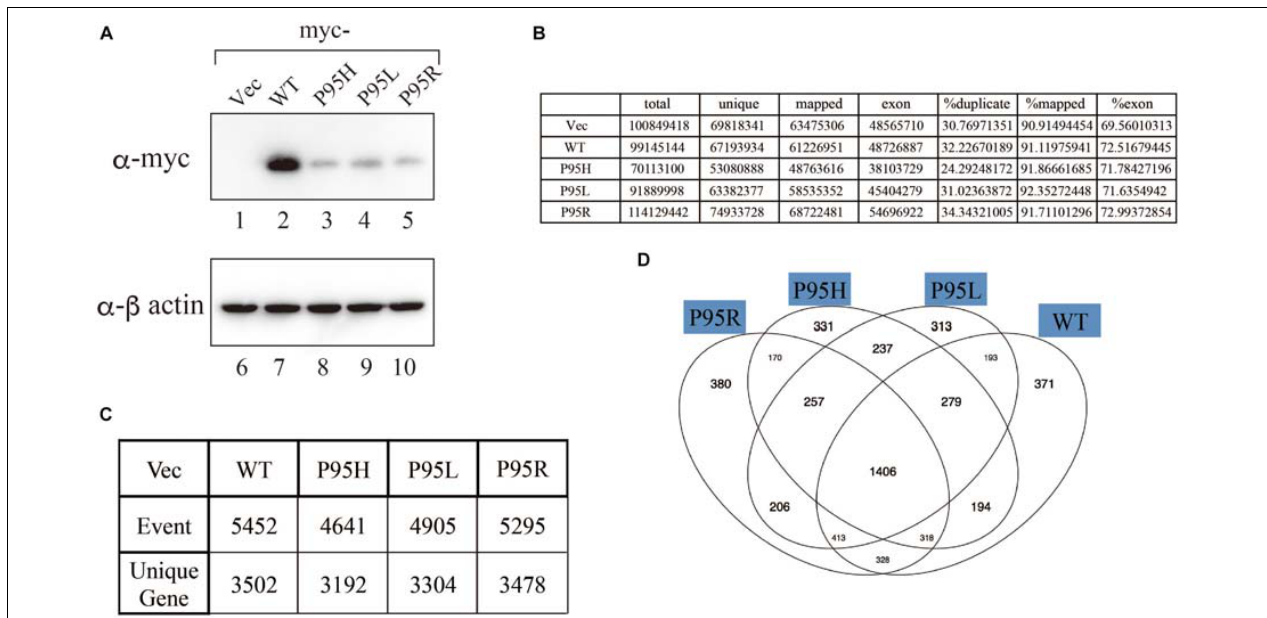
FIGURE 2 | Analyses of splicing changes in K562 cells stably expressing either wild-type or mutant SRSF2 protein. (A) Immunoblotting analyses of K562 cell lines stably expressing myc-tagged wild-type or mutant SRSF2 proteins. A myc-vector was used as a negative control. (B) Numbers of reads from RNA sequence analyses and mapping percentage of sequence tags. (C) Numbers of altered splicing events and genes identified by comparing with myc-vector transfected cells. (D) Venn diagram comparing the differentially spliced genes among myc-vector, WT and three SRSF2 mutants expressing